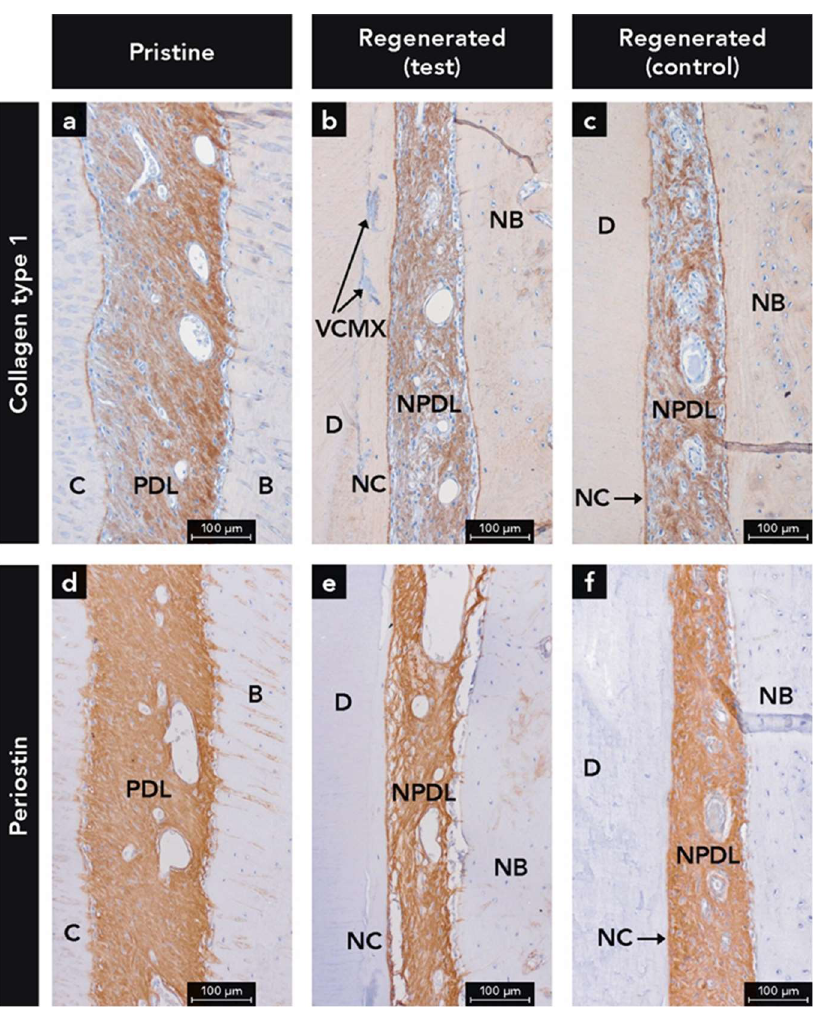
Figure 5. Micrographs demonstrating immunohistochemical staining for ( a , b , c ) collagen type 1 and ( d , e , f ) periostin; ( b ) Integration of residues of the volume stable collagen matrix (VCMX) in new cementum (NC); Counterstaining: Mayer’s hematoxylin; B, bone; C, cementum; D, dentin; NB, new bone; NPDL, new periodontal ligament; PDL, periodontal ligament.